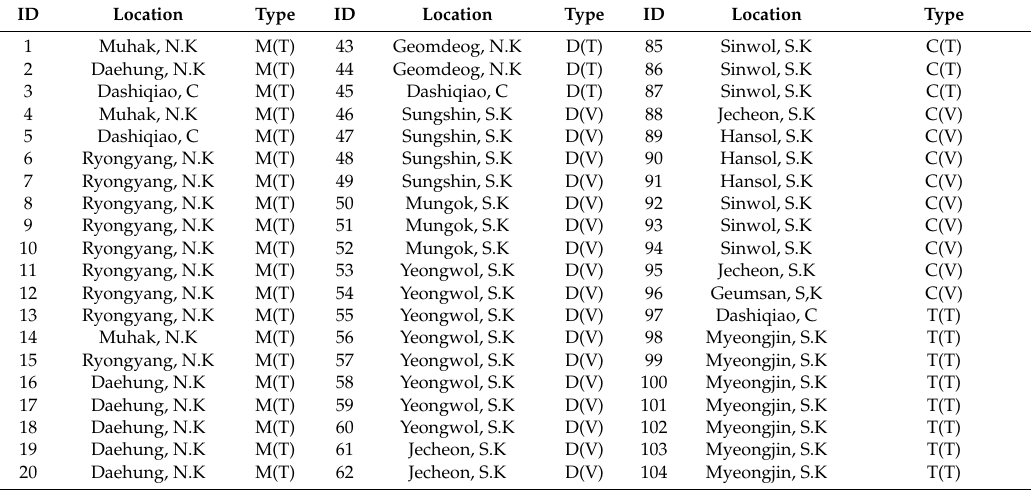
Table 1. The source locations and types of sample used in this